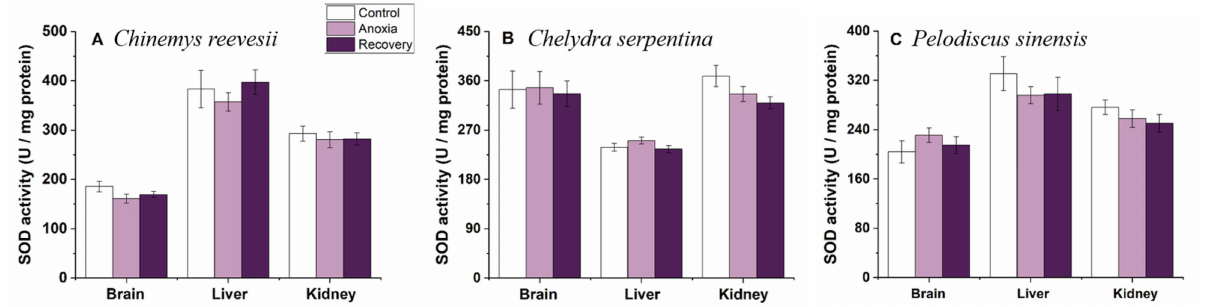
Figure 7. Changes of anoxia stress on SOD activity in tissues of C. reevesii ( A ), C. serpentina ( B ) and P. sinensis ( C ). Data are presented as mean ± SE. N = 10. Data with no common lowercase letters on the bar indicate significant differences between different groups ( p < 0.05).